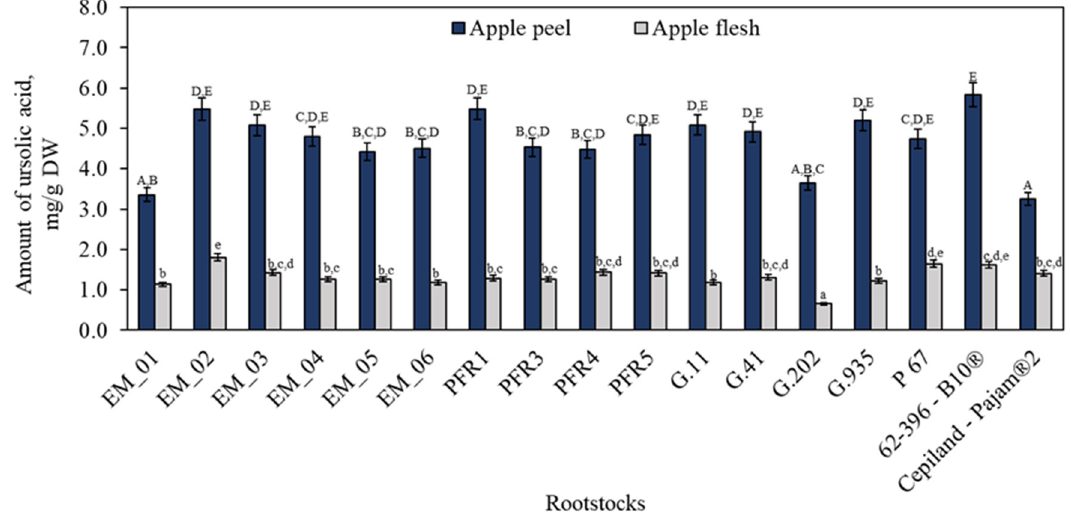
Figure 2. Influence of rootstocks on the quantitative composition of ursolic acid. The means followed by different uppercase and lowercase letters are significantly different at p < 0.05.